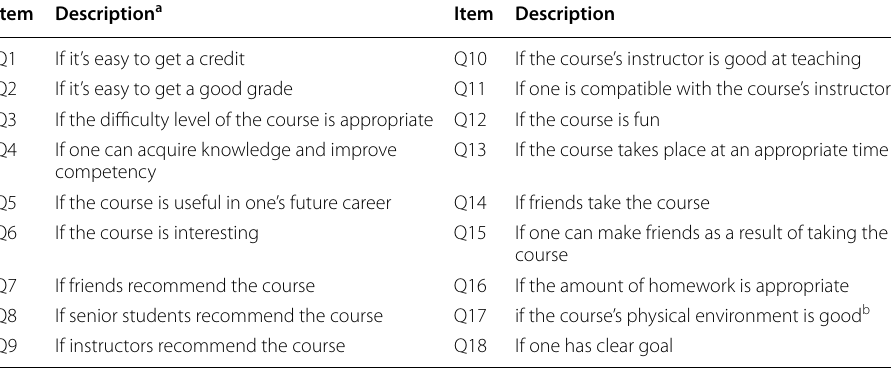
Table 1 Questionnaire regarding course selection